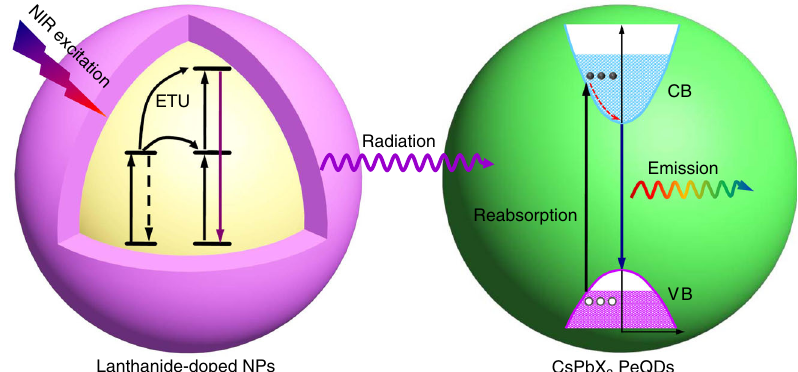
Fig. 1 Schematic representation of the radiative energy transfer upconversion (RETU) processes in all-inorganic CsPbX 3 perovskite quantum dots (PeQDs) through sensitization by lanthanide-doped nanoparticles (NPs). Lanthanide-doped NPs function as the energy donor to convert the NIR excitation light into the ultraviolet (UV) and visible emission light through successive photon absorption and energy transfer upconversion (ETU) processes within lanthanides. The emission light from the NPs is then reabsorbed by PeQDs to create electron – hole pairs (excitons) in the conduction band (CB) and valence band (VB), followed by photon emission through exciton recombination. The solid and dash lines represent the electronic